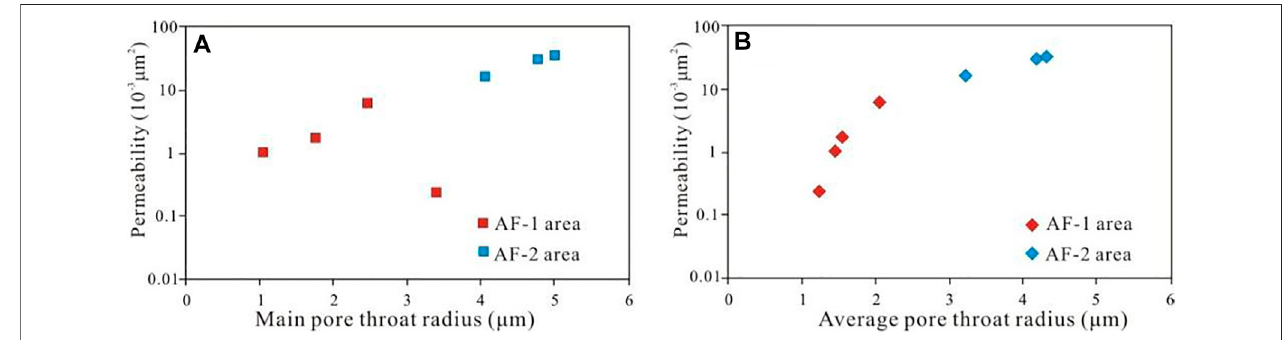
Frontiers in Earth Science |